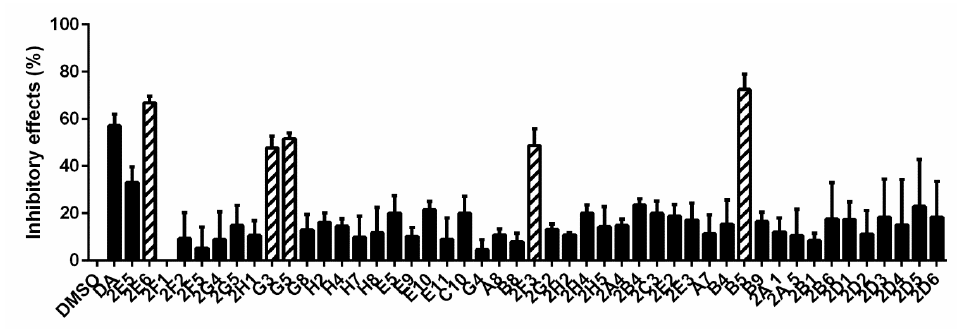
Figure 4. The calculated inhibitory effects of 47 natural products on B. microti determined by microscopy. The error bars indicate standard error of the means for each tested group. Five drugs (2E6, G3, G5, 2F3, and B5) with significant differences from DMSO were selected as potential drugs against B. microti . The drugs were in the sequence of DMSO, DA, 2E5, 2E6, 2F1, 2F2, 2F5, 2G4, 2G5, 2H1, G3, G5, G8, H2, H4, H7, H8, E5, E9, E10, E11, C10, G4, A8, B8, 2F3, 2G2, 2H2, 2H4, 2H5, 2A4, 2B4, 2C3, 2E2, 2E3, A7, B4, B5, B9, 2A1, 2A5, 2B1, 2B6, 2D1, 2D2, 2D3, 2D4, 2D5, and 2D6.